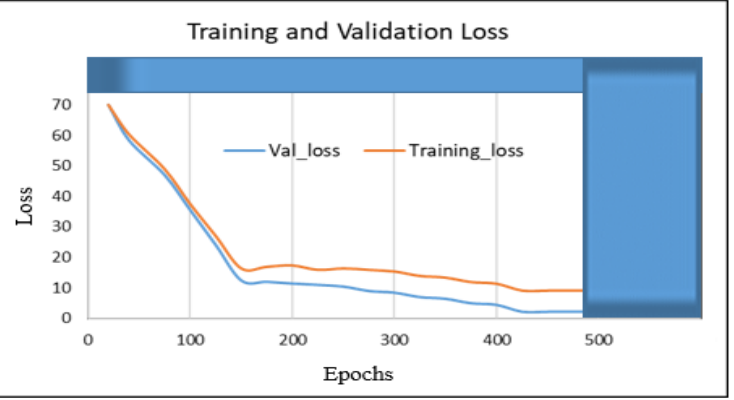
Figure 5. The proposed TSDCNN with 97.20% overall accuracy performance on vehicle matching rates across non-overlapping cameras with multiple angle views using the VRV dataset.